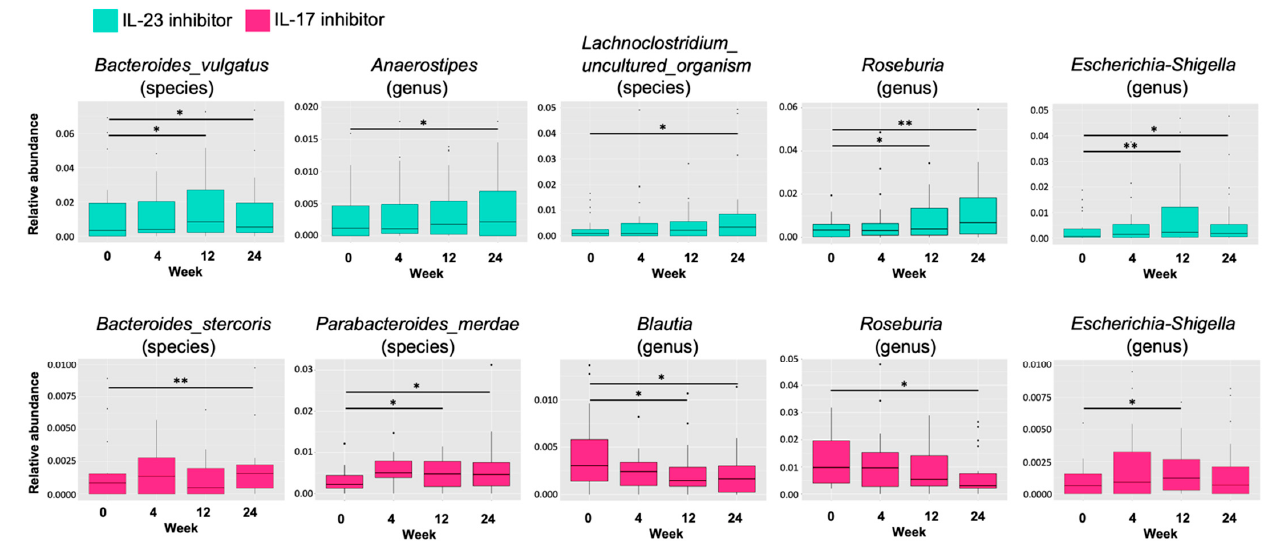
Figure 3. The relative abundance of specific gut microbial taxa during 24 weeks of treatment with IL-23 (guselkumab) or IL-17 (secukinumab and ixekizumab) inhibitors. Data are shown at each time point as box plots and represent 25–75% interquartile range of the median. (* p < 0.05, ** p <